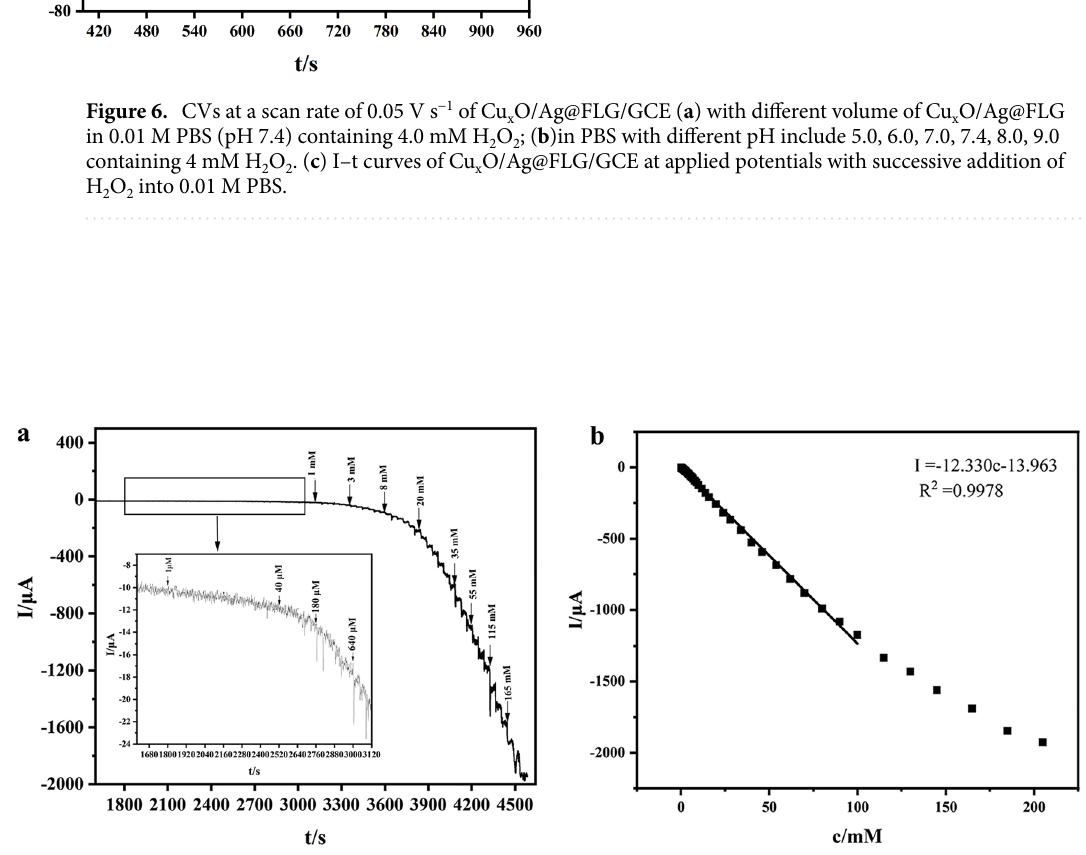
Figure 7. ( a ) I–t curve of the Cu x O/Ag@FLG/GCE for consecutive additions of H 2 O 2 at − 0.65 V. The illustration shows the enlarged i–t curve in the low concentration area; ( b ) corresponding fitting